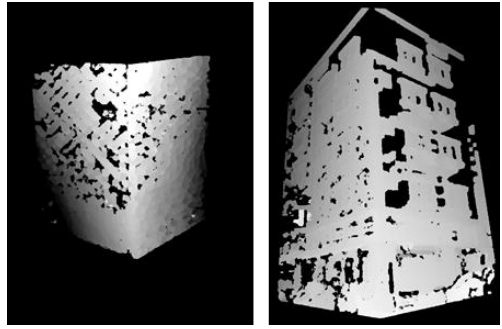
Figure 7. 3D point clouds from MDR